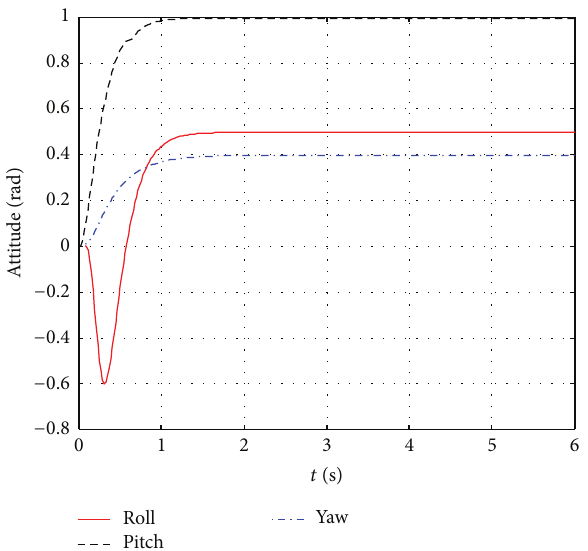
Figure 8: ZN-PD control responses of jointly controlling three attitude angles to the expectations.